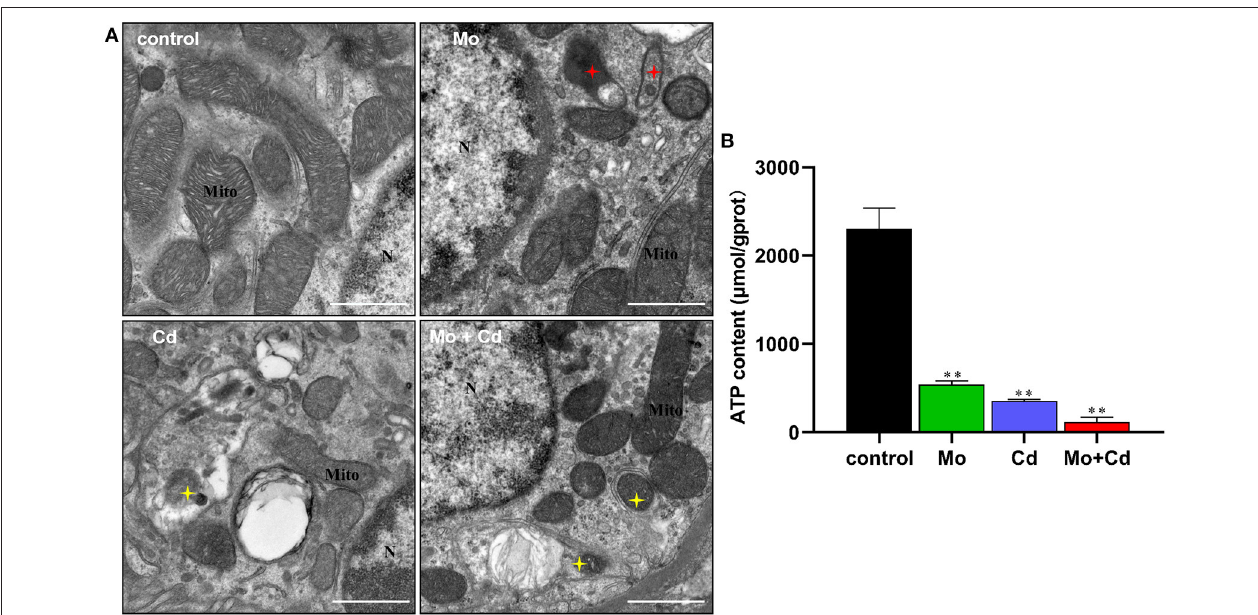
FIGURE 3 | Effect of Mo or/and Cd on ATP level and ultrastructure of the kidney. (A) The ultrastructural structure of the kidney. Red asterisks mark vacuole-mitochondria. Yellow asterisks indicate mitophagosomes. “N” means nucleus, “Mite” means mitochondrion, scale bar = 1 µ m. (B) ATP content. Data are expressed as means ± SD ( n = 6). “*” indicates significant difference compared to the corresponding control (* P < 0.05, ** P < 0.01). “#” indicates statistically significant difference between corresponding groups ( # P < 0.05, ## P <